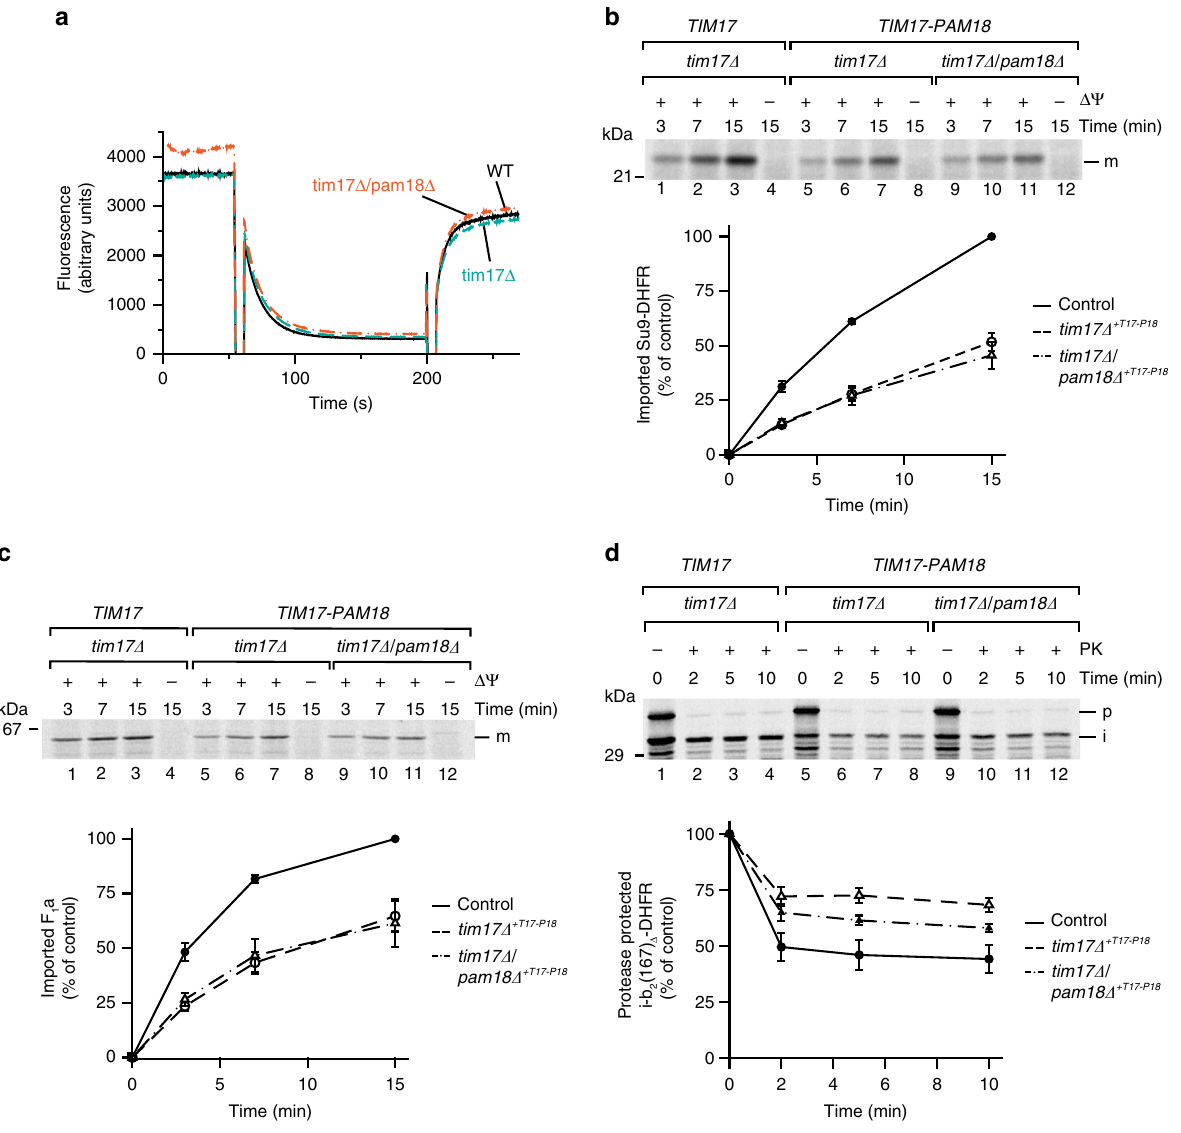
Fig. 2 Mitochondria containing a Tim17 – Pam18 fusion display mild-matrix import defects. a Membrane potential ( Δψ ) of mitochondria was assessed using the Δψ -sensitive dye DiSC 3 (5). Fluorescence quenching by mitochondria was recorded before and after addition of valinomycin. b , c [ 35 S]-labeled precursor proteins were imported into the mitochondria and import stopped after indicated time points using antimycin A, valinomycin, and oligomycin (AVO). Samples were Proteinase K (PK)-treated and analyzed by SDS-PAGE and digital autoradiography. Results are presented as mean ± SEM, n = 3. The longest import time of the WT sample was set to 100%. m, mature protein; tim17 Δ + T17-P18 tim17 Δ + TIM17 – PAM18 . d The inward-driving force of the import motor was assessed using [ 35 S]-labeled b 2 (167) Δ -DHFR in the presence of methotrexate (MTX). After 15 min import, Δψ was dissipated using valinomycin. In a second step, the precursor was chased for indicated time before PK addition. The amount of processed intermediate was quanti fi ed (100%: amount of processed intermediate without protease treatment). Results are shown as mean ± SEM, n = 4. p, precursor; i,